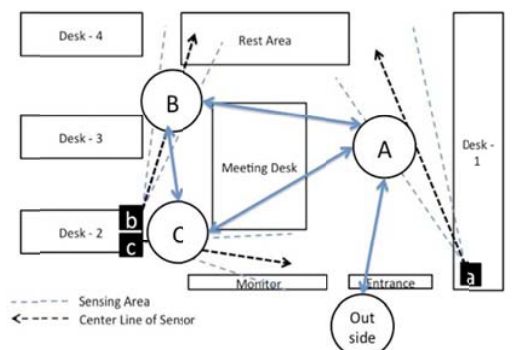
Figure 8: Room- by changes in lowered but so